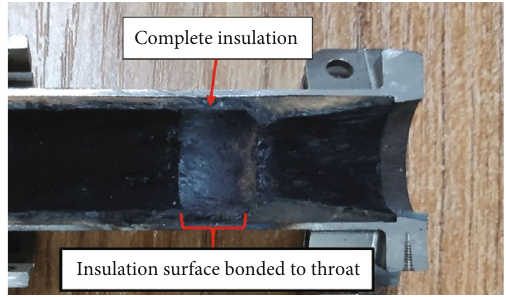
Figure 14: Sectional view of improved tail-pipe